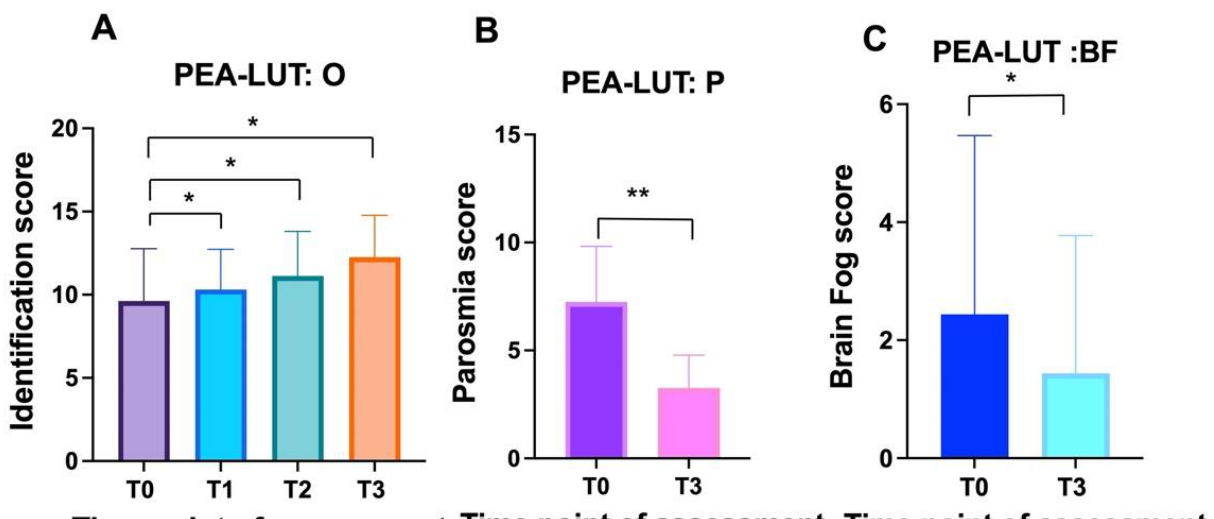
Figure 5. Effect of PEA-LUT treatment without olfactory training on olfaction, parosmia, and mental clouding in patients without prior olfactory training (Naïve 2 group): ( A ) O (olfaction) results of identification test at T0 (baseline), T1 (1 month), T2 (2 months), and T3 (3 months); ( B ) P (parosmia) before (T0) and after three months (T3) of treatment; ( C ) BF (brain fog/mental clouding) before (T0) and after three months (T3) of treatment. **: p < 0.01; *: p < 0.05.